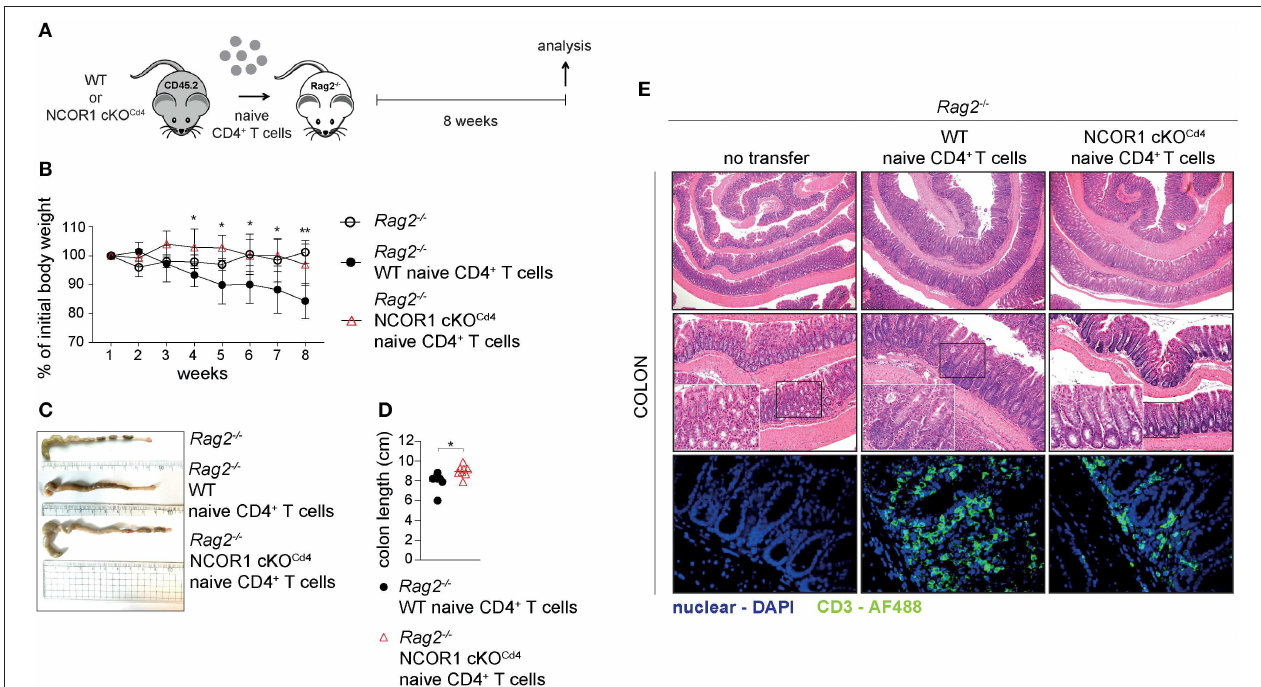
FIGURE 5 | Attenuated induction of colitis by NCOR1-deficient CD4 + T cells. (A) Experimental set up: Naïve WT or NCOR1 cKO Cd4 CD4 + T cells were i.p. injected into Rag2 − / − mice. Eight weeks later, recipient mice were immunophenotyped and analyzed for signs of colitis. Control Rag2 − / − groups did not receive any cells. (B) Diagram showing body weight during the course of the experiment. Body weight at the indicated time point was calculated relative to the initial body weight. (C) Representative pictures show colon length of Rag2 − / − control mice and of Rag2 − / − mice that have received either naïve WT or NCOR1 cKO Cd4 CD4 + T cells. (D) Diagram shows colon length of Rag2 − / − mice that have received either naïve WT or NCOR1 cKO Cd4 CD4 + T cells. Length was measured without cecum. (E) Colon swiss rolls were processed for H&E stainings (upper and middle panel). The white rectangle framed pictures in the lower left corner of the middle panel pictures show a 4x magnification of the black rectangle framed section. The lower panel shows immunofluorescence stainings. Color code: blue, nuclei; green, CD3 + T cells. Magnification: H&E stainings (upper panel: 40x; middle panel: 100x; and 400x for zoomed in sections) and immunofluorescence stainings (lower panel: 400x). (D) Horizontal bar indicates the mean. * P < 0.05, ** P < 0.01 (unpaired two-tailed t -test). Data are representative (C,E) or show summary (B,D) of 7–8 (B–E) mice that were analyzed in 2–3 independent